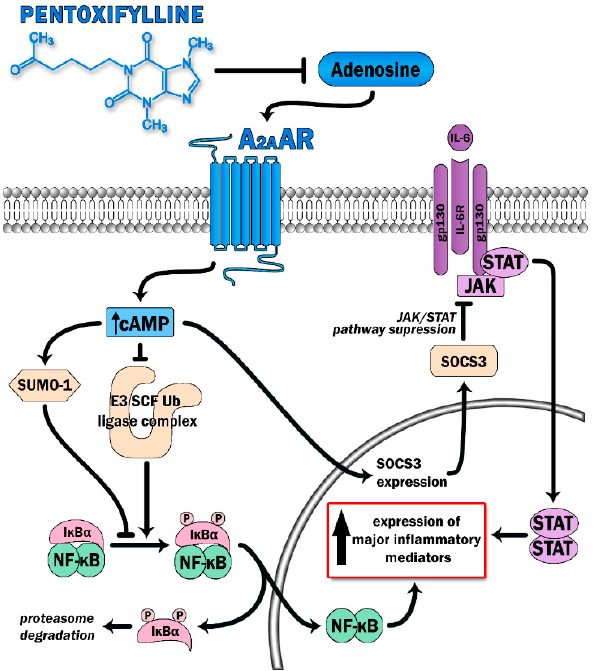
Figure 1. Pentoxifylline is able to dampen activation of two major proinflammatory signaling pathways (the NF κ B and JAK-STAT) via antagonist effect on adenosine binding with its receptor (A 2A AR). Triggering A 2A AR causes elevation of intracellular cAMP levels. This leads to increase SUMO-1 activity along with inhibition of the E3 SCF Ub ligase complex, which prevents I κ B α ubiq- uitination and degradation, thereby switching off the NF κ B pathway. Moreover, high cAMP levels suppress cytokine-mediated JAK/STAT signaling via induction of the inhibitory protein SOCS3.